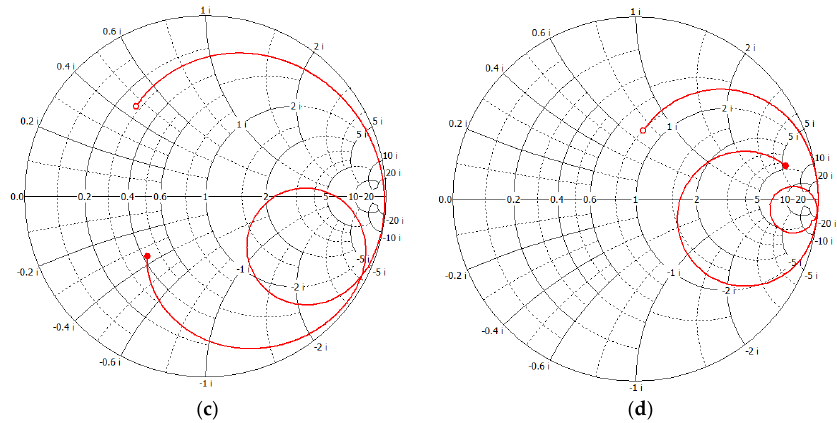
Figure 4. Reflection and transmission properties in the simulated design. ( a ) Reflection vs transmission; ( b ) Transmission characteristics; ( c , d ) Transmission characteristics using the Smith chart of the unit cell along propagation (normalized impedance 376.7 and 50 ohms).